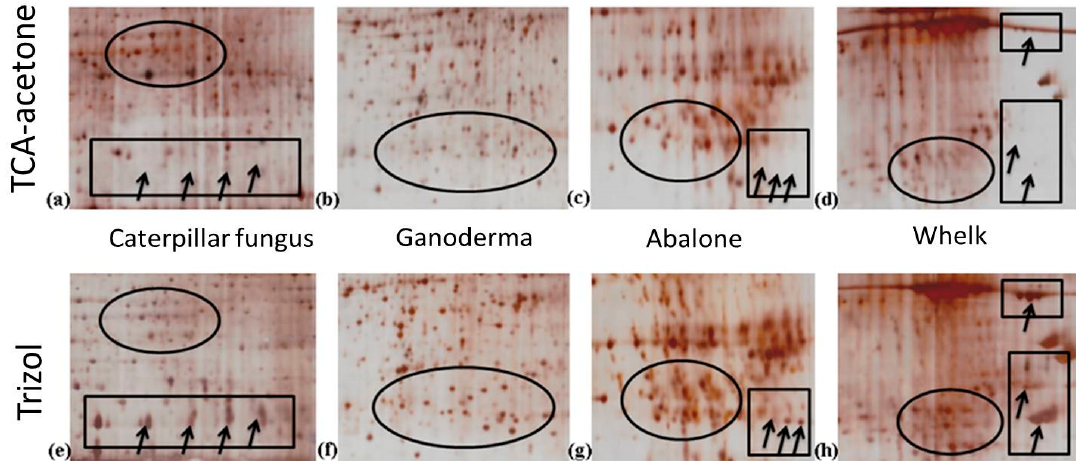
Figure 4. The enlargement of selected regions of 2-DE gels of caterpillar fungus ( a , e ), ganoderma ( b , f ), abalone ( c , g ), and whelk ( d , h ) samples. Circle areas in ( a , e ) indicated the background difference. Circle areas in ( b – d ) and ( f – h ) indicated the differences of intensity of spots. Square areas indicated the missing of protein spots. Arrows indicate the differentially expressed protein spots between the gels.